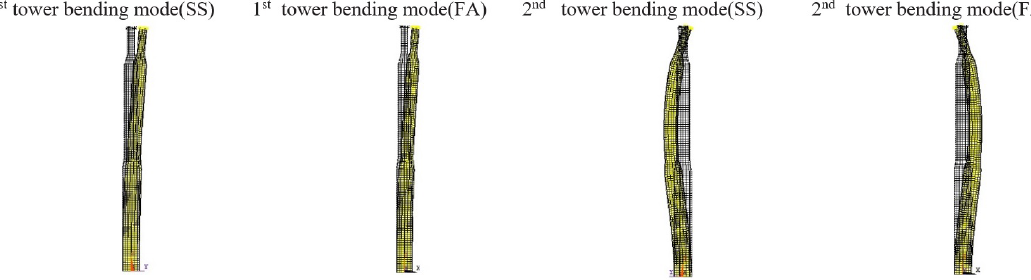
Figure 5. Mode shapes of the first and second tower bending pair modes.